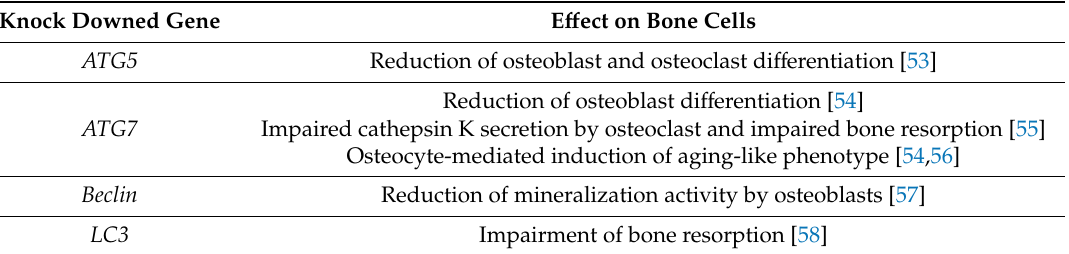
Table 1. Knockdown of autophagy genes and e ff ects on bone remodeling activity. Knock Downed